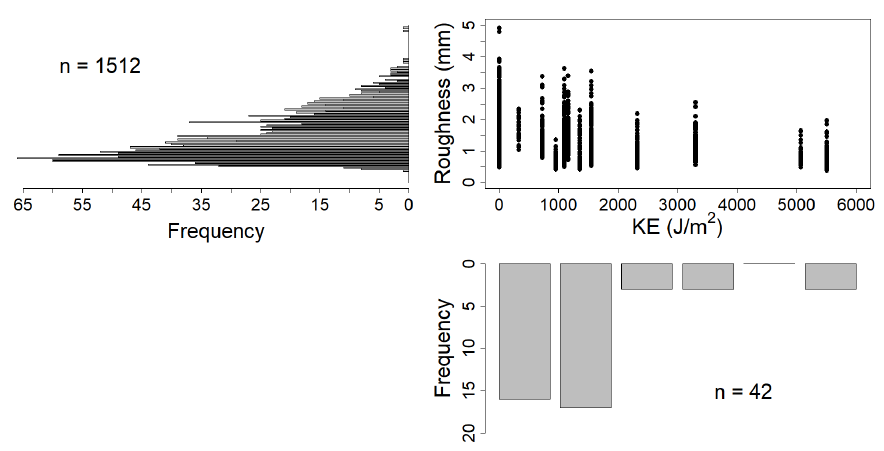
Figure 8. Scatterplot of KE in J/m 2 and measured roughness in mm of standard deviation, detailed for the 2 mm resolution. Data histograms are plotted side by side to the respective axes.